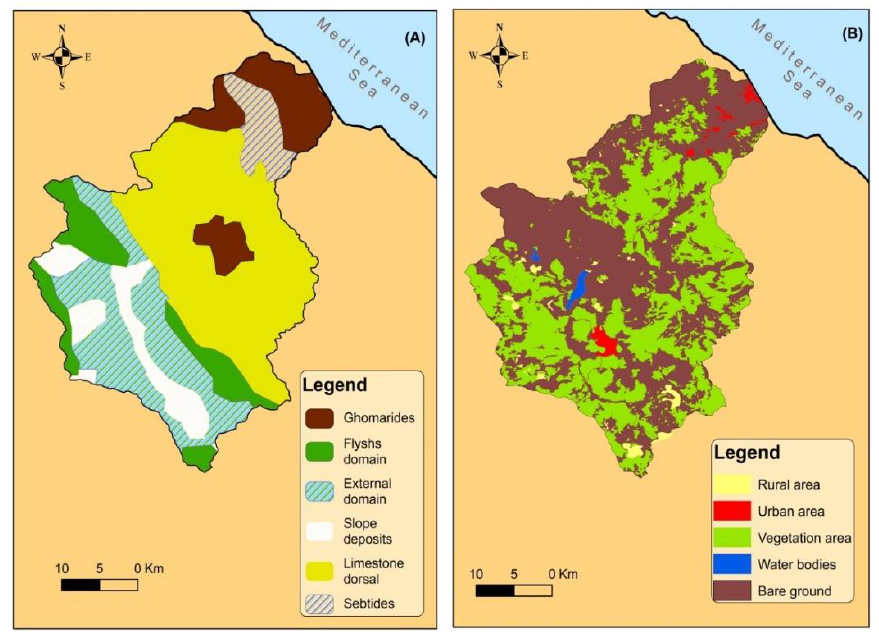
Figure 3. ( A ) Geologic map of OLW and ( B ) land-use map of OLW from Landsat 8 (resolution 30